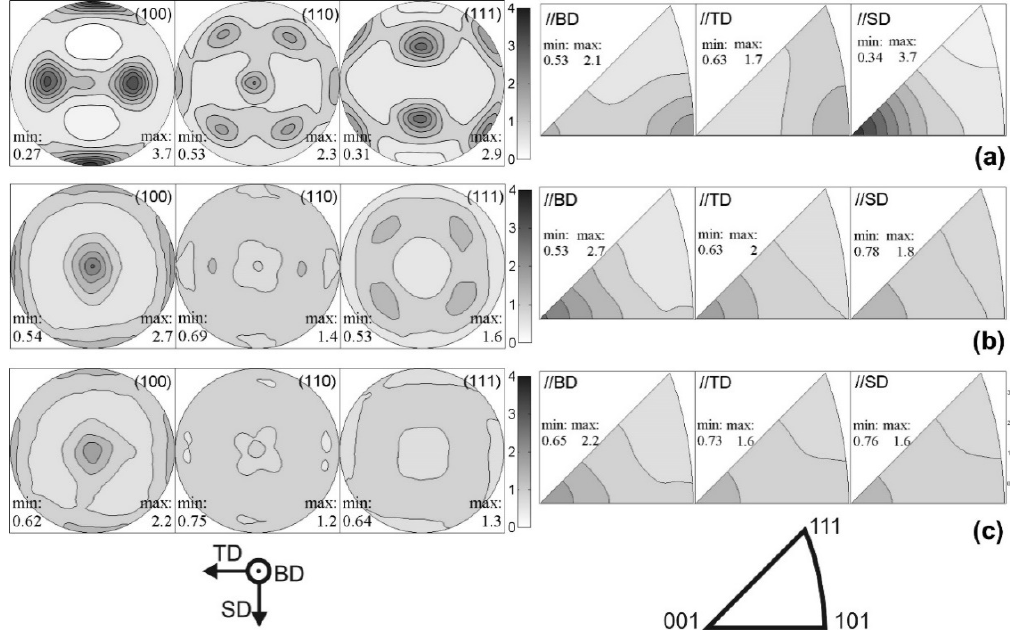
Figure 42. AlSi10Mg SLM samples showing pole and inverse pole figures as a function of different scanning strategy. The building direction (BD) is correlated to the (1 0 0) pole figures and the scanning direction (SD) and the transverse direction (TD) are correlated to the (1 1 0) and (1 1 1) pole figure data. The figures correspond to: ( a ) unidirectional long scans, ( b ) bidirectional long scans with the vectors rotated to 90° and ( c ) an island scanning strategy without shift. The orientation of the coordinate system is displayed by the relative intensity of the diffraction peaks compared to the reference sample indicated in grey scale [71]. Copyright 2012. Adapted with permission from Elsevier Science